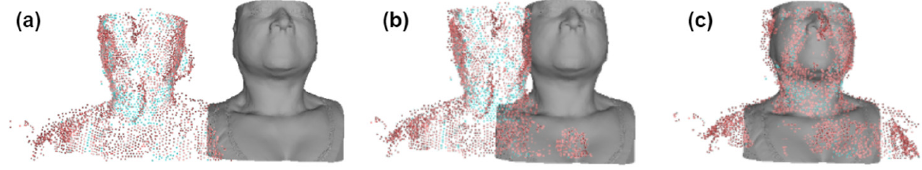
Figure 9. Alignment visualization: ( a ) pre-alignment; ( b ) during alignment; ( c ) post-alignment.